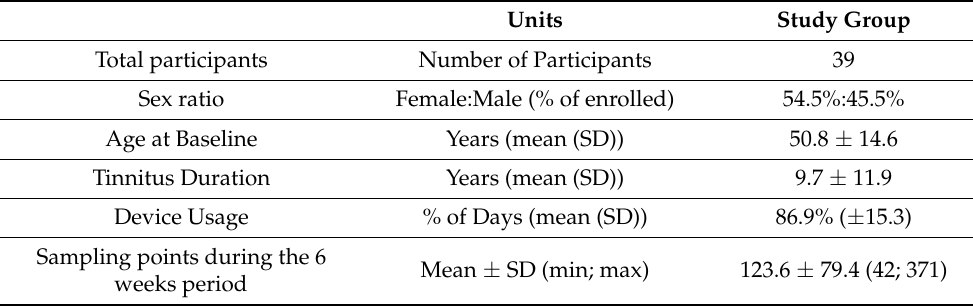
Table 2. Characteristics of the study